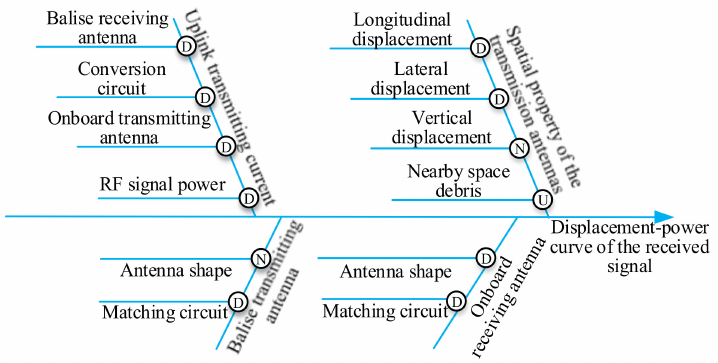
Figure 2. Fishbone diagram of the influencing factors of the uplink received